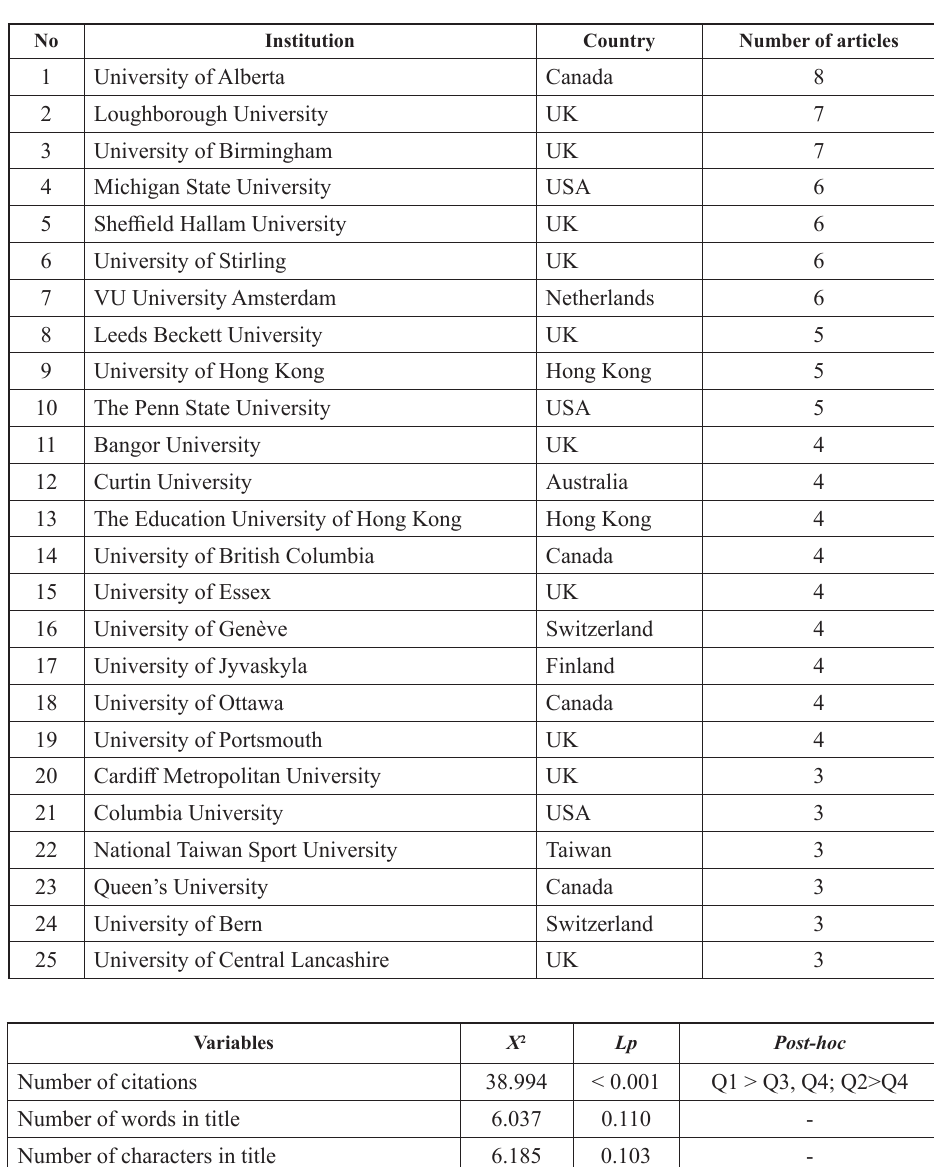
Table 3. Differences be - tween four quartiles ac- cording to selected jour-